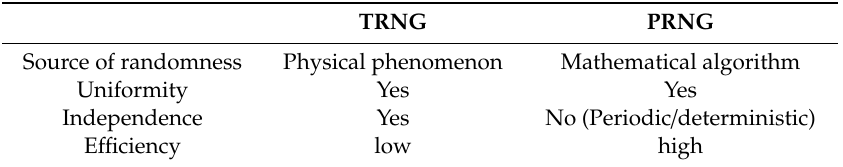
Table 1. Comparison between a true random number generator TRNG and a pseudo-random number generator